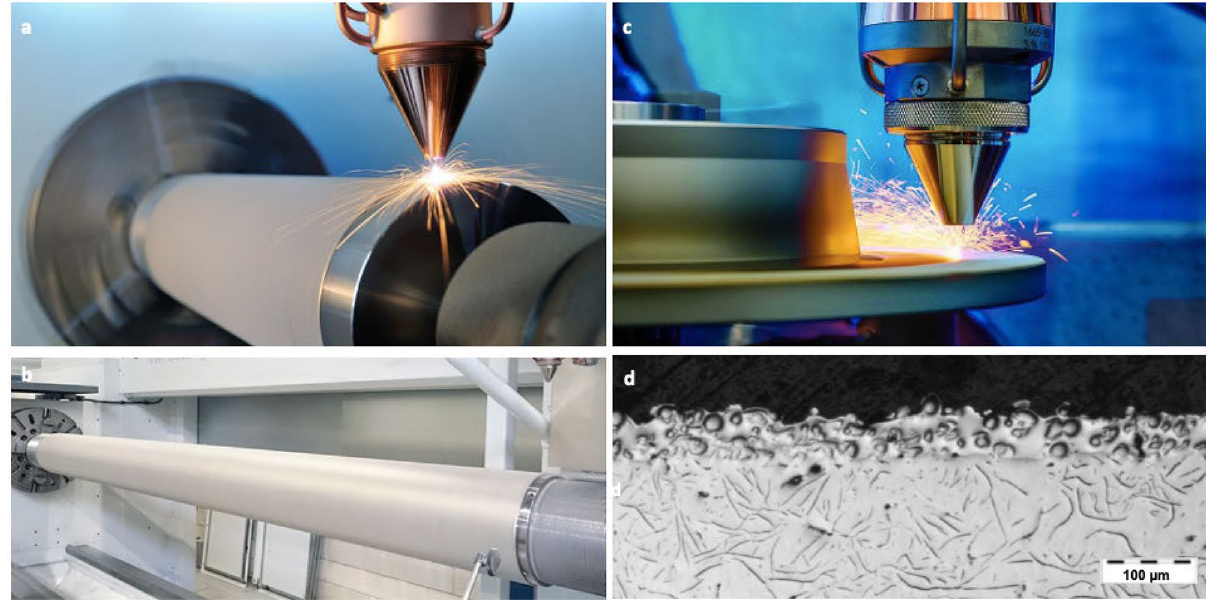
Figure 4. Industrial applications. ( a ) A piston rod, which is being coated. ( b ) One cladded piston rod. ( c ) Cladding of brake disc for automobile industry for wear resistance. ( d ) A cross-section of the cladded brake